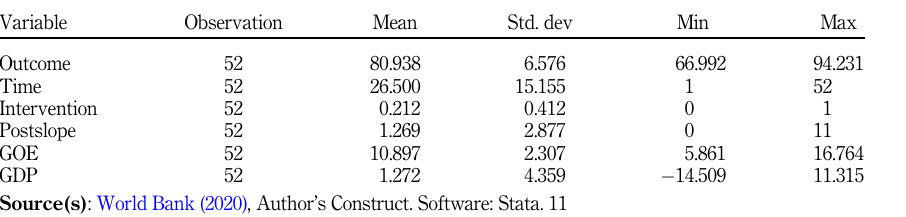
Table 1. Summary statistics